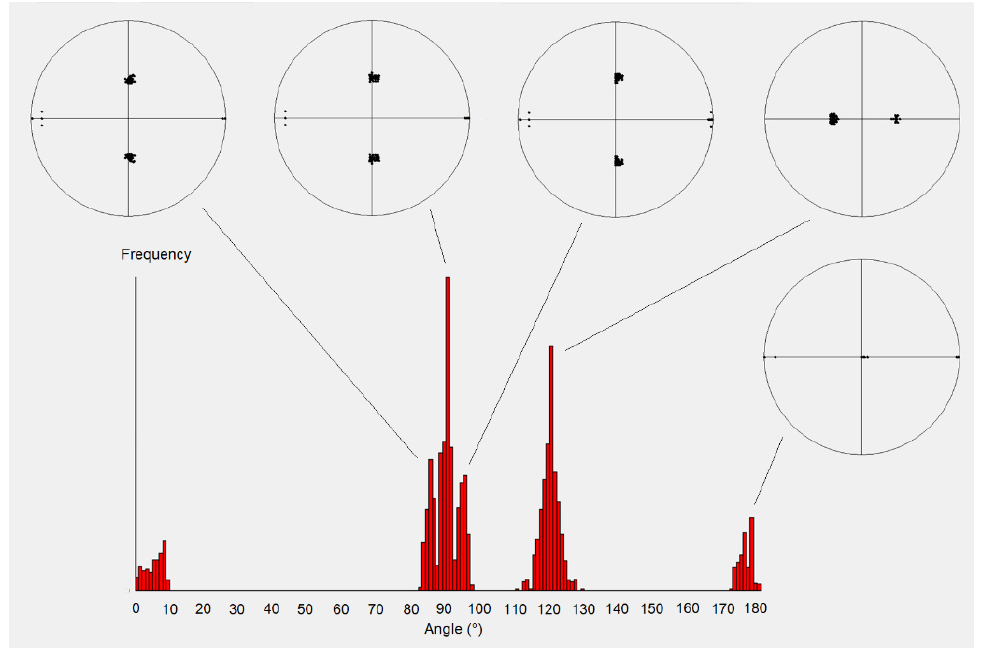
Figure 4. Theoretical disorientation histogram and rotation axes built from all the orientation variants of all the closing-gap ORs presented in Table 4.